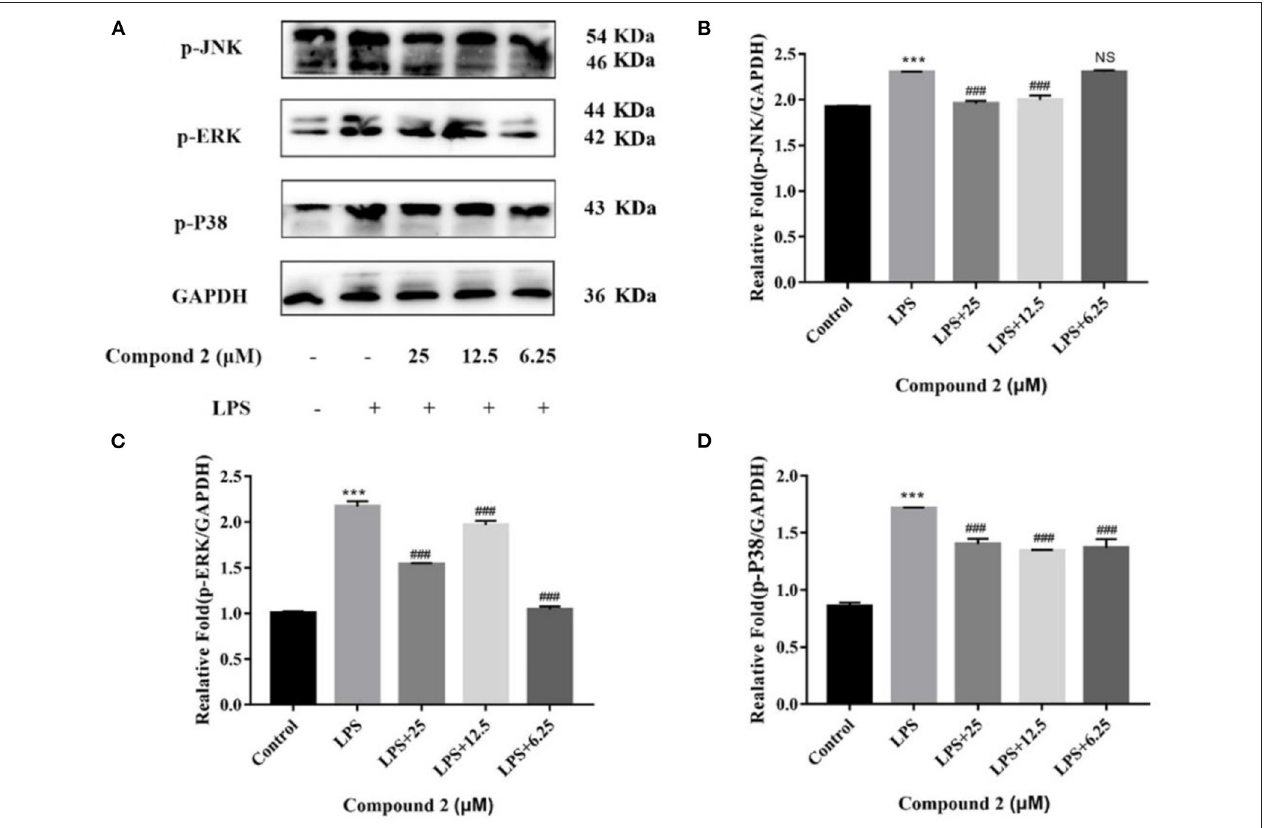
FIGURE 7 | Influences of compound 2 on the MAPK pathway detected by Western blotting. (A) The expression levels of p-JNK, p-ERK, p-P38, and GAPDH detected by the western blotting. (B) The proportion of p-JNK to GAPDH content. (C) The proportion of p-ERK to GAPDH content. (D) The proportion of p-P38 to GAPDH content. Data rendered are the mean ± SD, n = 3. In comparison to the control, *** P < 0.001. In comparison to the LPS, ### P < 0.001.